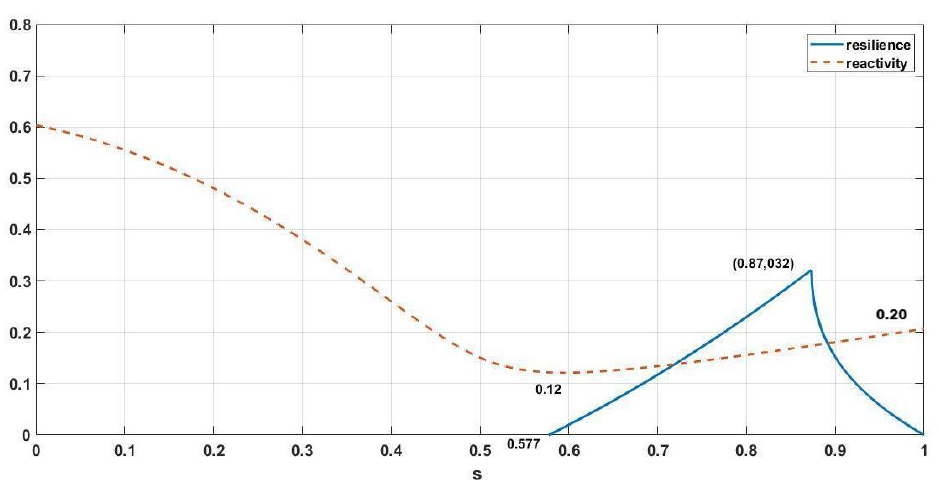
Figure 4. Resilience and reactivity of system (7) (in the mean square sense). Disturbance to prey ( σ 1 = 0.4, σ 1 = 0.8 and σ 2 = 0